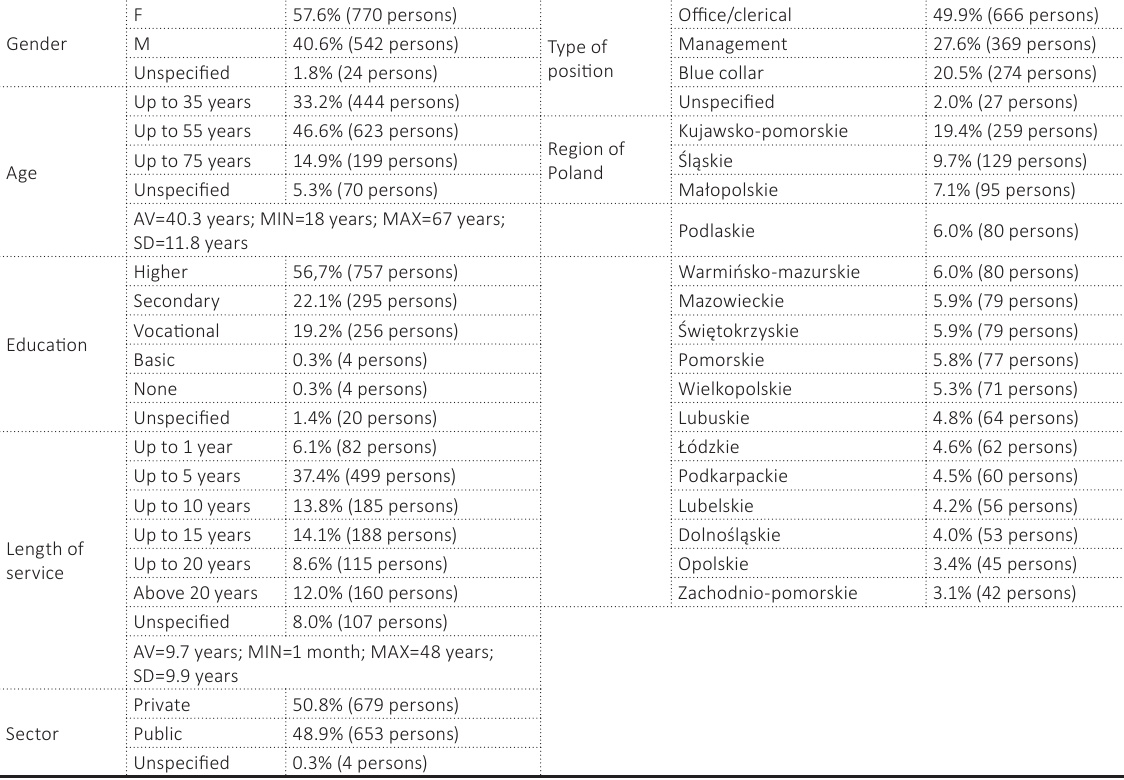
Table 2. Demographic characteristics of the sample